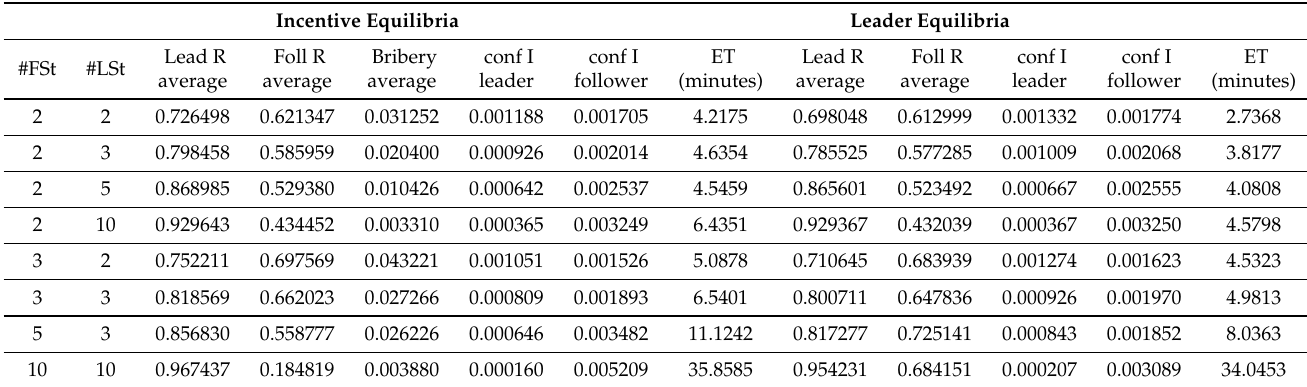
Table 12. Values using continuous payoffs in the range 0 to 1.